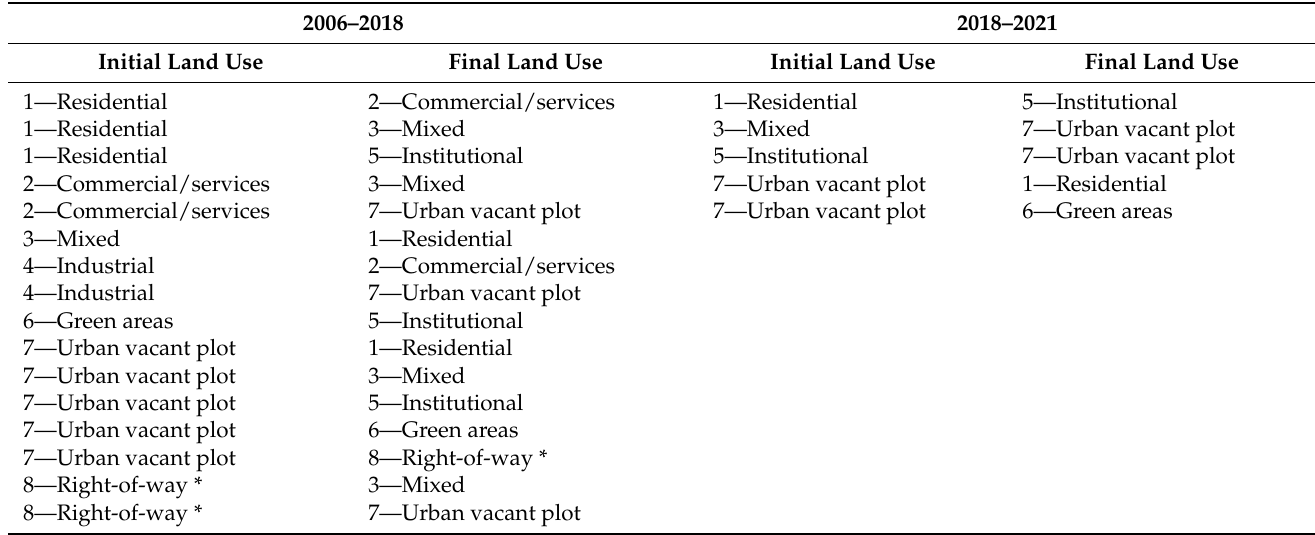
Table 1. Land use transitions observed in the analyzed simulation periods. The colors are associated with the respective classes in the land use maps.